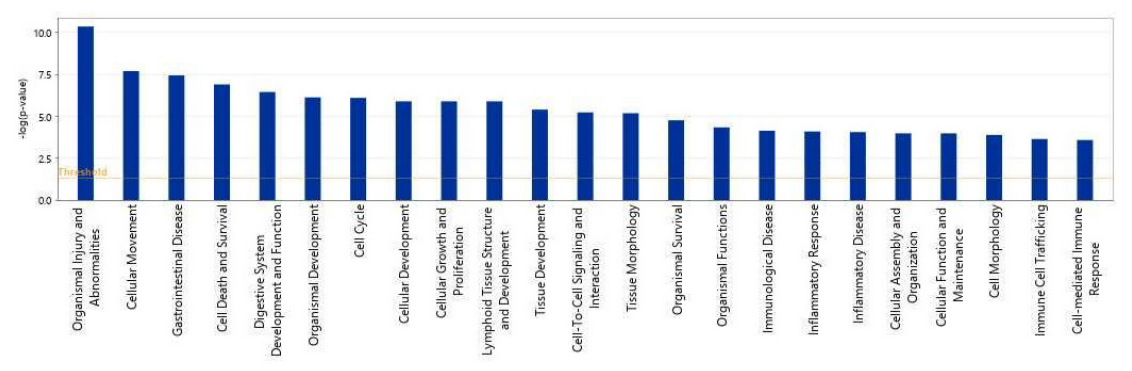
Figure 6. Top biological processes impacted by acidic bile salt treatment of HEMFS. Significance values are displayed as − log of the p -value, calculated by the right-tailed Fisher’s exact test and which measures the likelihood of association between molecules in our dataset and a pathway by random chance alone. Threshold denotes − log (0.05) = 1.3; taller bars equate to increased significance.